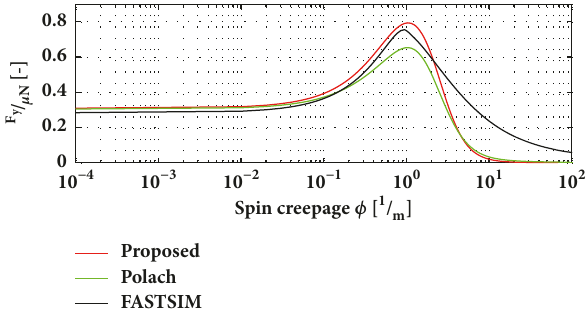
Figure 7: Longitudinal force versus longitudinal creepage in pres- ence of a constant spin creepage ( 𝜙 = 0.2).